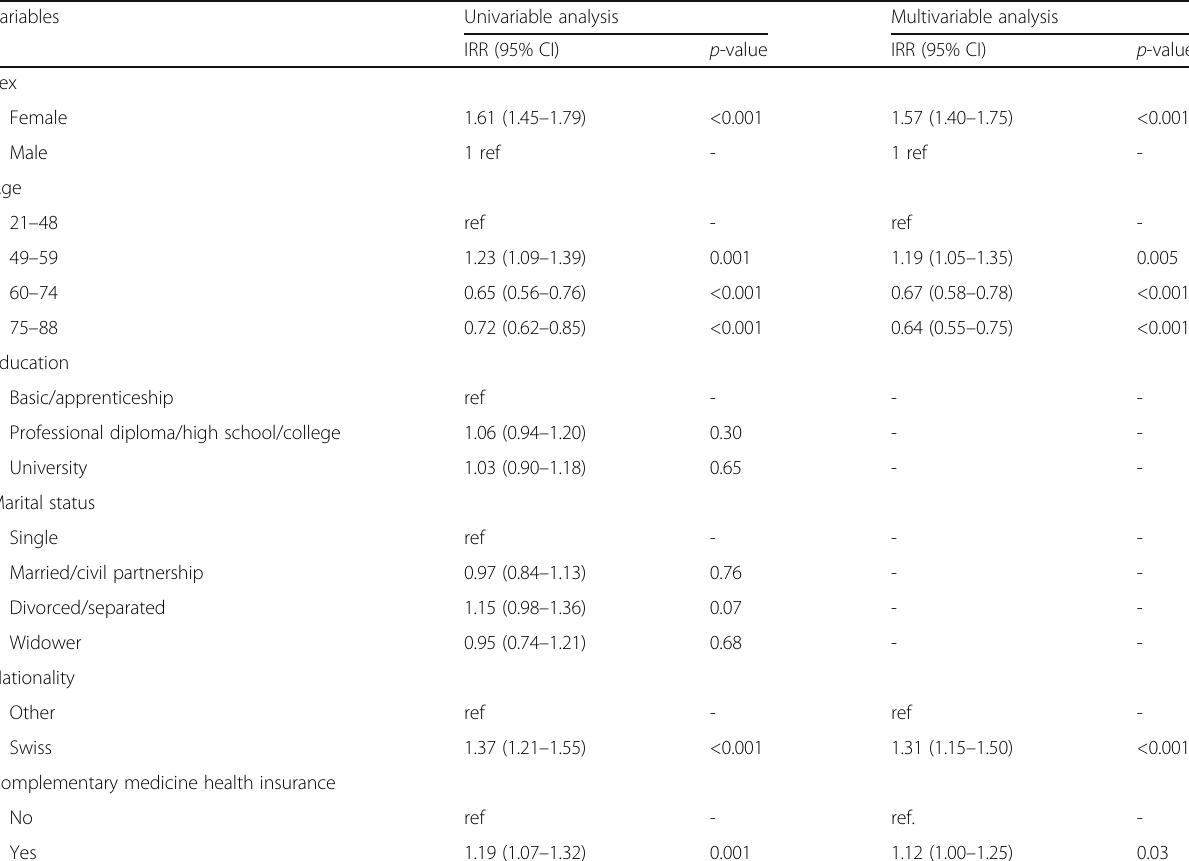
Table 3 Poisson regression analysis of patients ’ knowledge regarding complementary medicine and associated factors